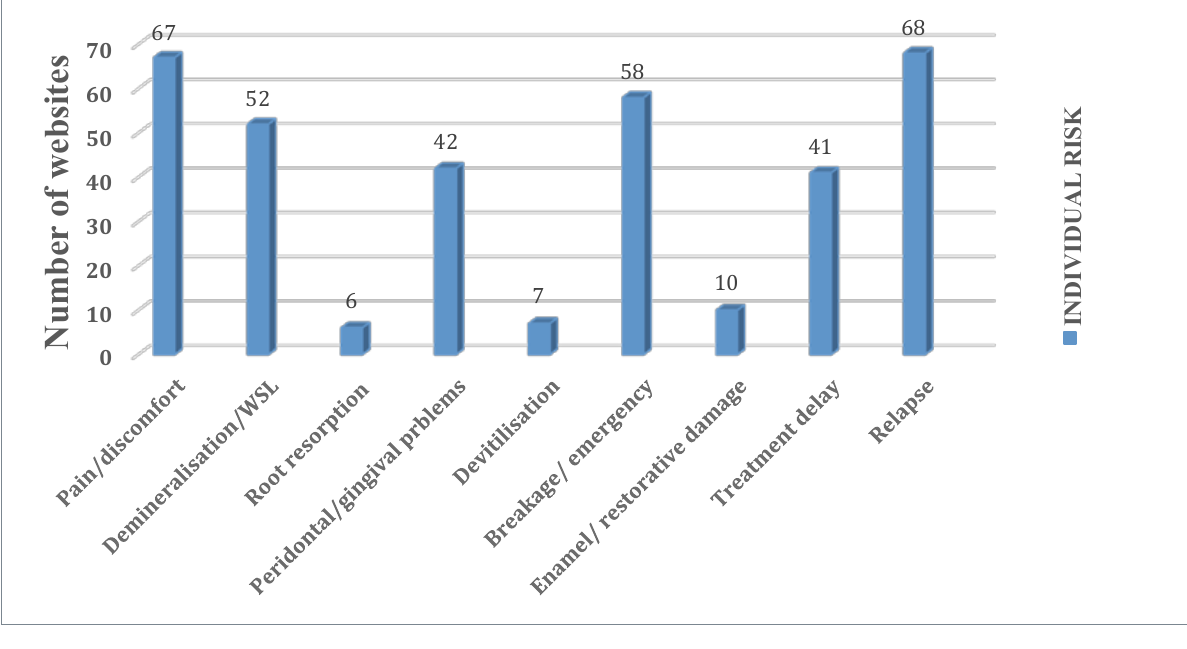
Table IV. DISCERN scores for reliability, quality of information and overall rating score